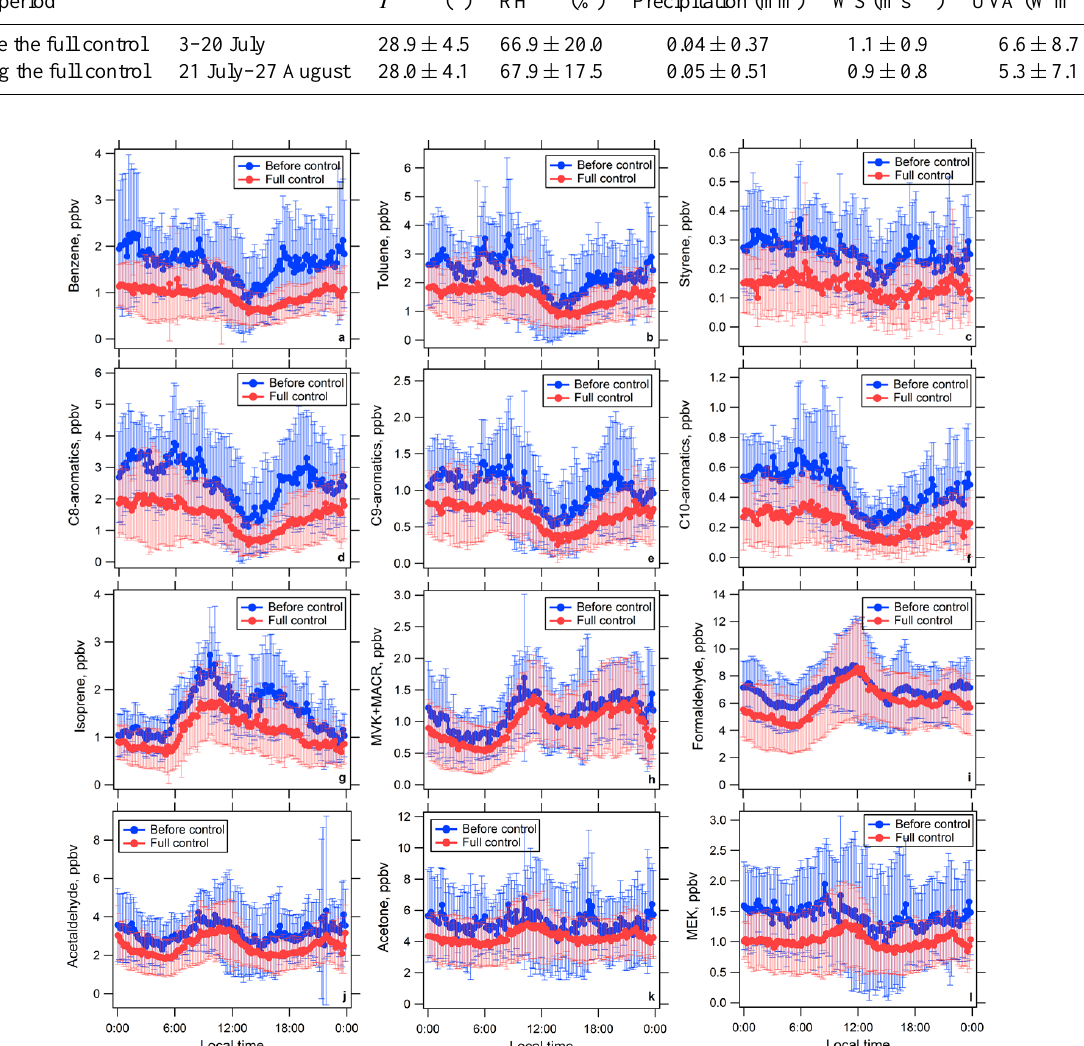
Figure 1. The 10min average diurnal variations of several NMHCs and OVOCs measured by PTR-MS at the PKU site before (1–20 July, blue) and during the full control (21 July–27 August, red), respectively. (a) benzene, (b) toluene, (c) styrene, (d) C8 aromatics, (e) C9 aromatics, (f) C10 aromatics, (g) isoprene, (h) MVK + MACR, (i) formaldehyde, (j) acetaldehyde, (k) acetone, (l) MEK. The error bars represent standard deviations (SDs) for those compounds before (blue) and during the full control